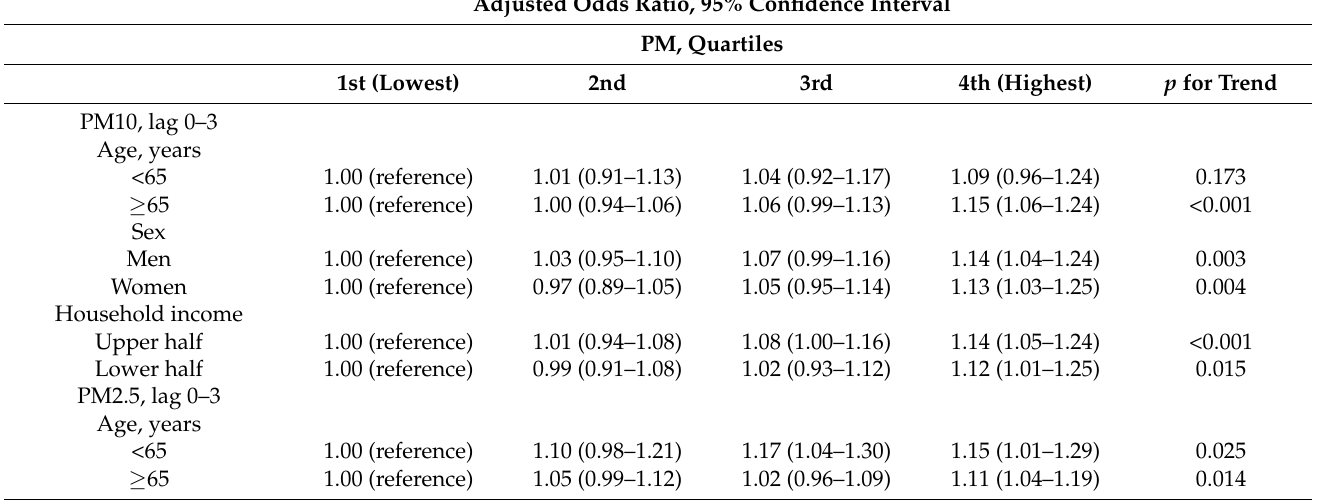
Table 2. Stratified analysis on the association of short-term PM with cardiovascular disease among 5-year cancer survivors according to subgroups of age, sex, and household income.